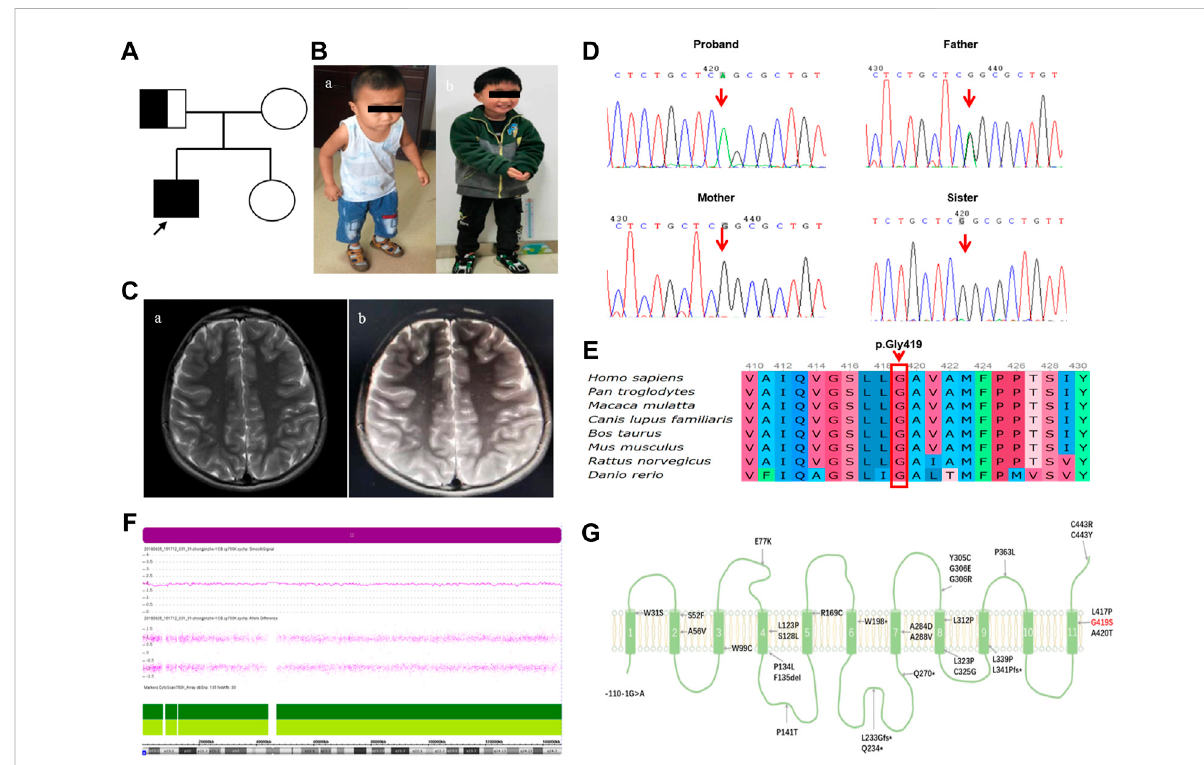
FIGURE 1 The patient ’ s clinical phenotype, neuroimaging features, and genetic outcomes are shown. (A) Pedigree map of BVVL caused by UPD(8)pat. (B) Clinical phenotype of a child with BVVL (Ba At the age of 3.4 years; Bb At the age of 6.8 years). (C) Brain MRI images of follow-up patients with BVVL (Ca showed normal head MRI at the age of 3.4 years; Cb showed bilateral parietal lobe T2WI high signal at the age of 6.8 years). (D) Sanger sequencing revealed a missense mutation in the SLC52A2 gene in the proband (c. 1255G > A). His father was heterozygous, his mother was normal,andhissisterwasnormal. (E) Conservationofthep.Gly419Servariantfoundedinthisstudy. (F) Array-CGHidenti fi edUPD(8)byshowingLOH across chromosome 8. (G) Schematic diagram of RFVT2 protein transmembrane domain. The red font represents the mutation carried by the present case, while the black font represents the mutation reported in previous